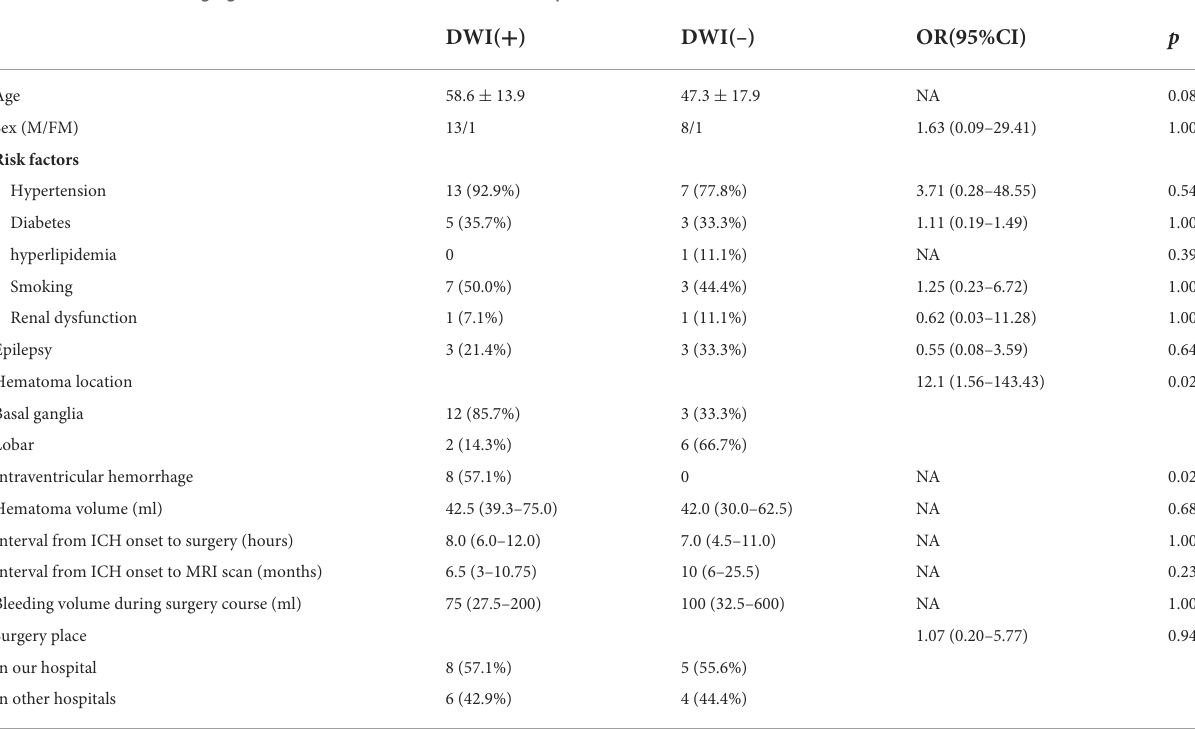
TABLE 1 Clinical and imaging characteristics of DWI ( + ) and DWI (–) patients of